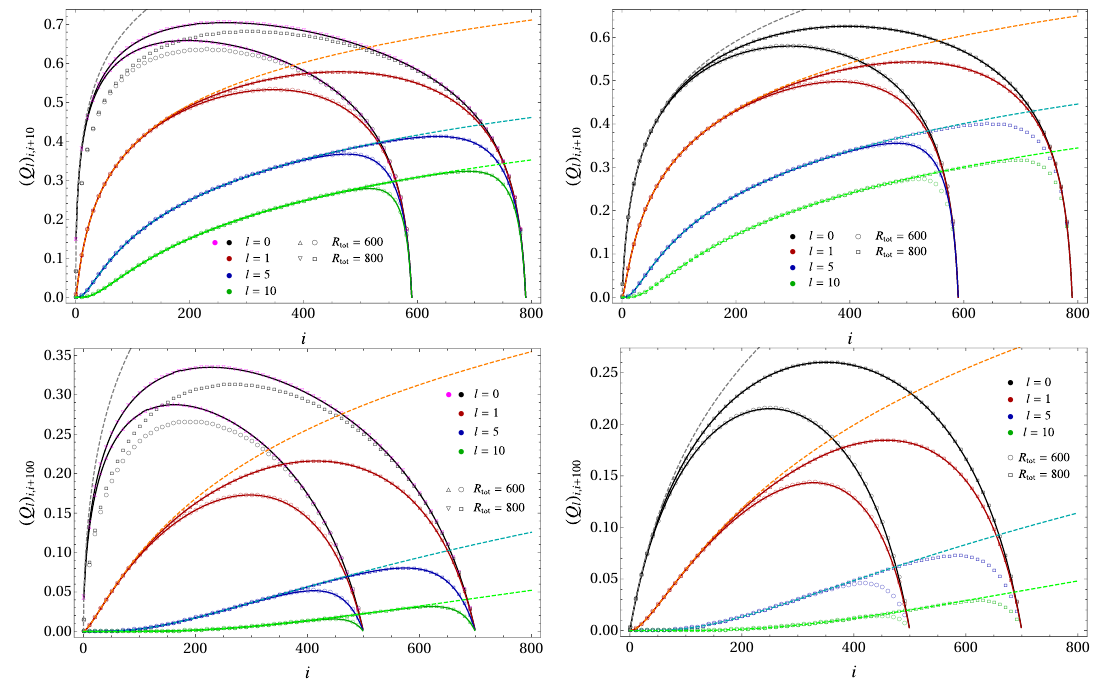
Figure 12. Correlators (2.15) in the massless regime: Q i,i +10 (top panels) and Q i,i +100 (bottom panels) for d = 2 (left panels) and d = 3 (right panels) evaluated from (2.14) with ω = 0 and for systems whose total size is given by R ∈ { 600 , 800 } . The dashed lines correspond to (A.7) and tot the solid ones to (A.11) with m = 0 . The magenta data points in the left panels are obtained from (A.16) with ω = 0